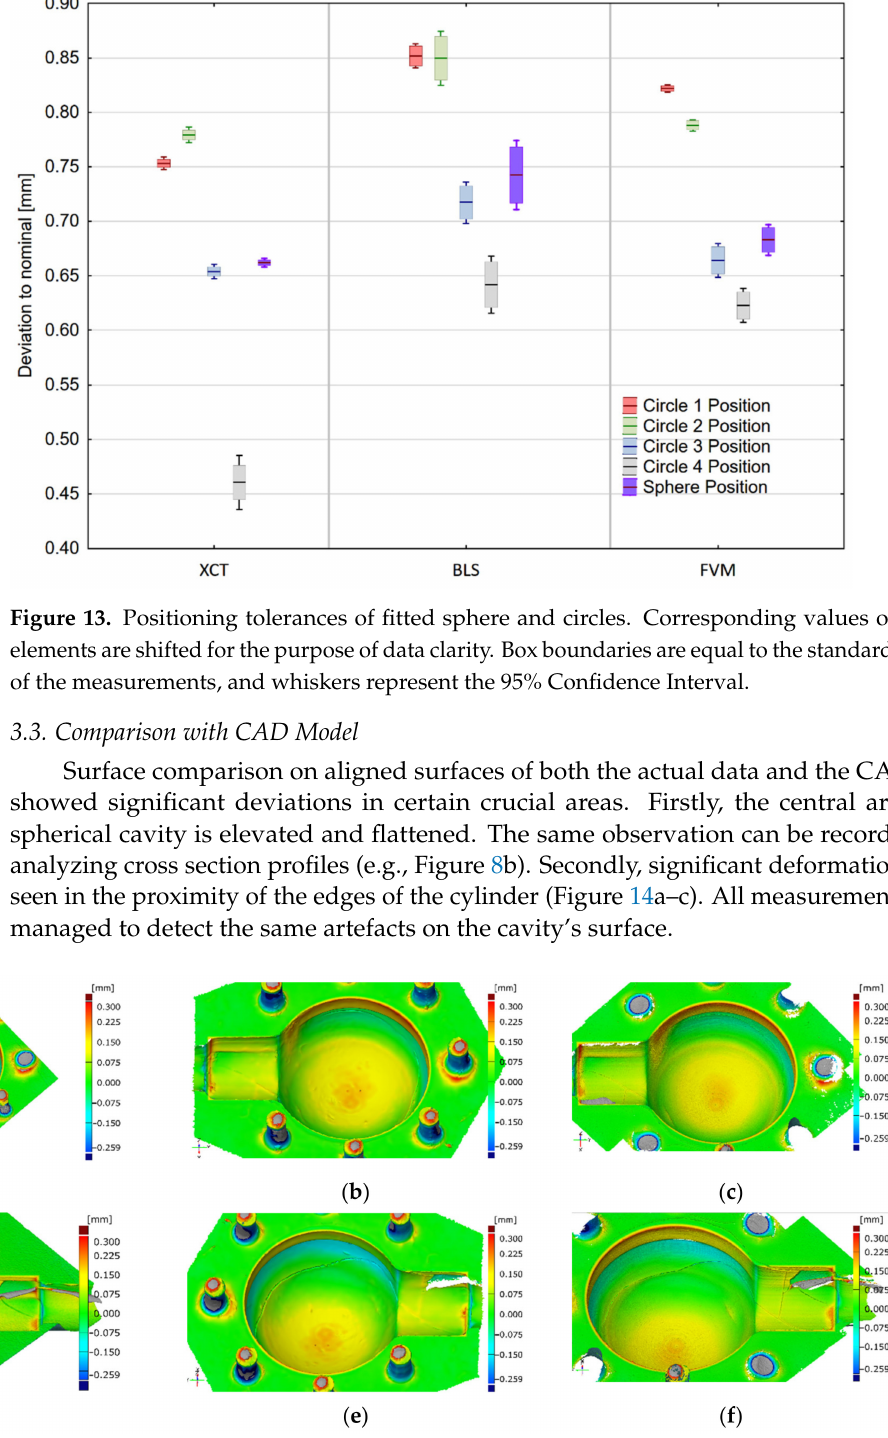
Figure 14. Surface comparison of measured element: ( a ) and ( d )—XCT; ( b ) and ( e )—BLS; ( c ) and ( f